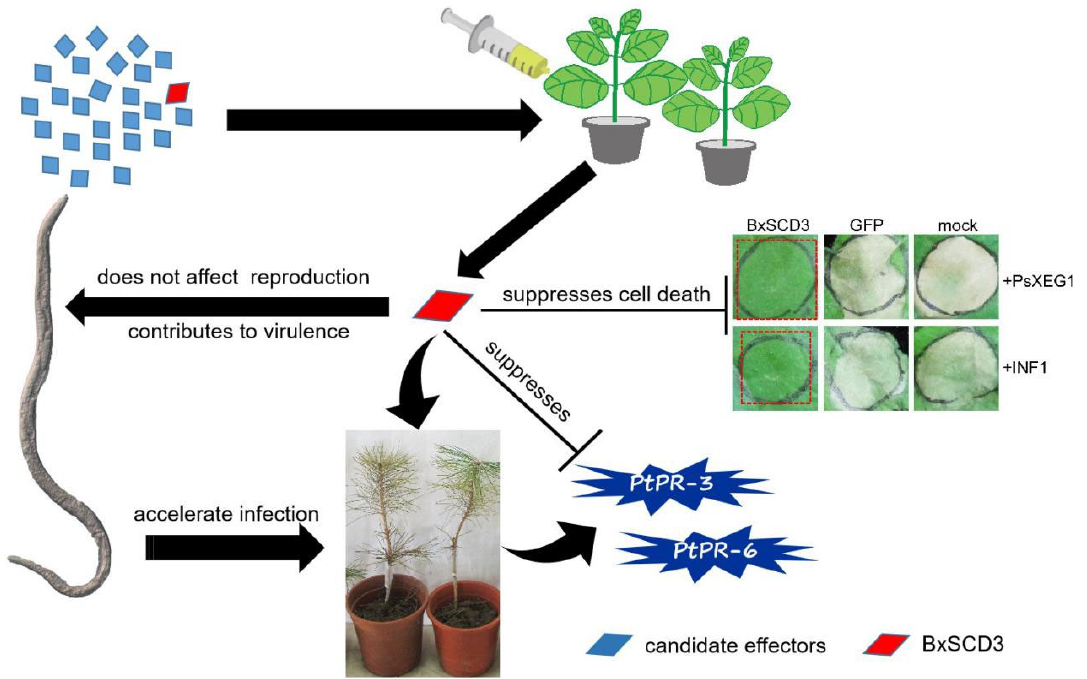
Figure 7. Functional diagram of BxSCD3. BxSCD3 was identified as an effector by agrobacterium- mediated transient expression in Nicotiana benthamiana , which suppressed PAMPs PsXEG1- and INF1-triggered cell death. BxSCD3 contributes to the virulence, does not affect reproduction of Bur- saphelenchus xylophilus in the process of interaction between B. xylophilus and pines, and significantly suppresses the relative expression levels of defense-related (PR) genes PtPR-3 and PtPR-6 in Pinus thunbergii , which accelerates the infection progress of B. xylophilus